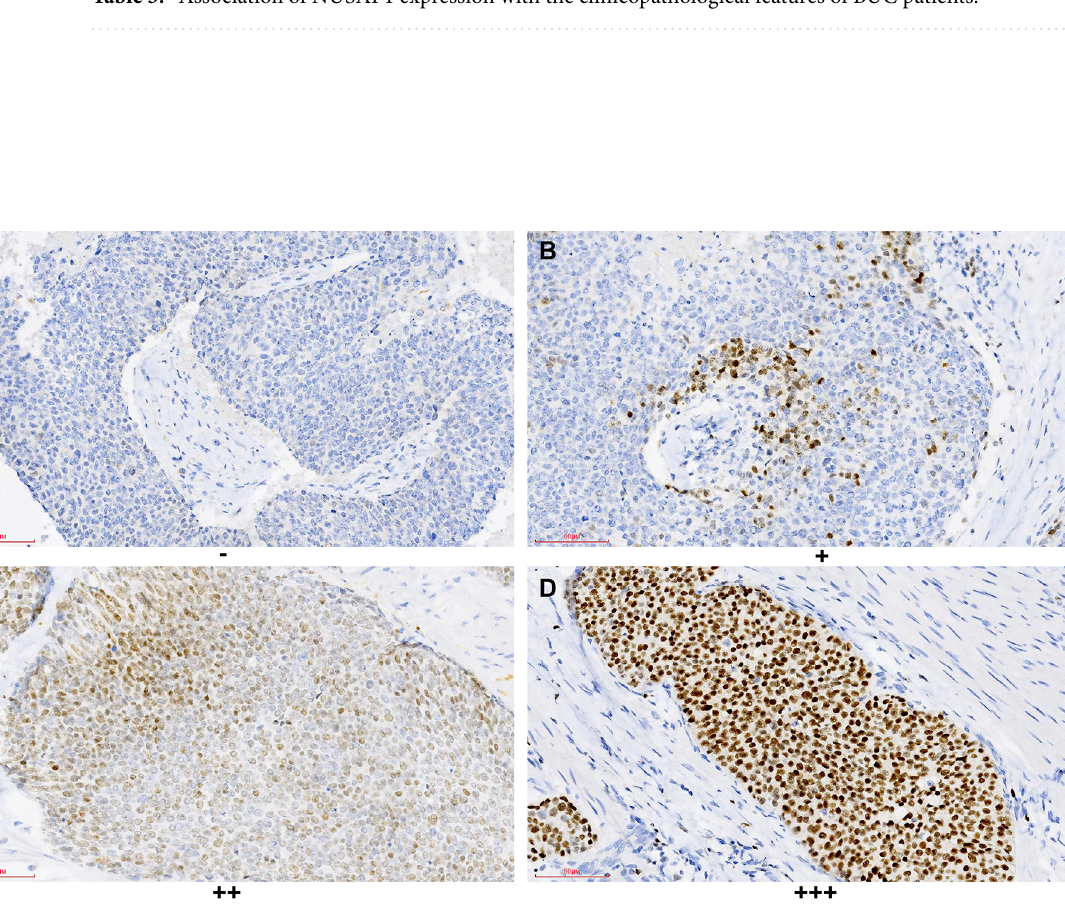
Table 3. Association of NUSAP1 expression with the clinicopathological features of BUC patients.